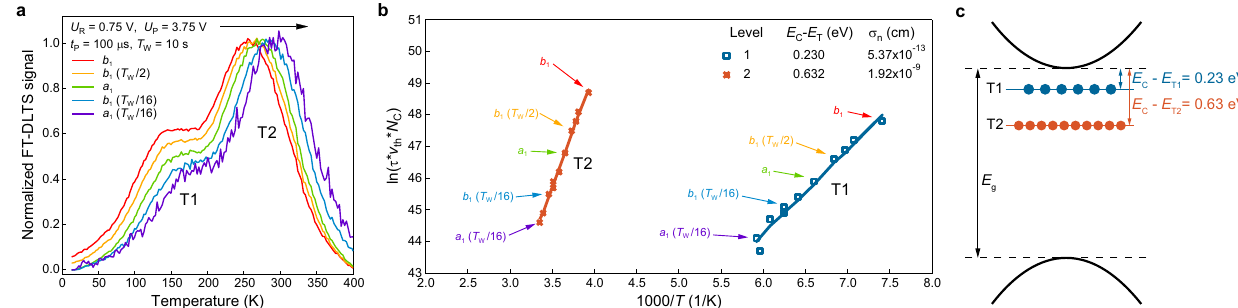
Fig.2|Defectlevelsinsingle-crystalMoS 2 characterizedbyDLTS.a Normalized Fourier transform DLTS signal measured using different correlation functions, showing two types of defect states (T1 and T2). Here, b 1 , b 1 ð T W = 2 Þ , a 1 , b 1 ð T W = 16 Þ , a ð T = 16 Þ are 5 correlation functions usedasexamples to demonstrate peakshifts 1 W with different rate windows. The reference voltage U R is fi xed at 0.75 V, pulse voltage U P at 3.75 V, pulse width t P at 100 μ s, and the period width T W at 10 s. b Arrhenius fi tsobtained frompanela,showingthetwo detected trapstates.Here,